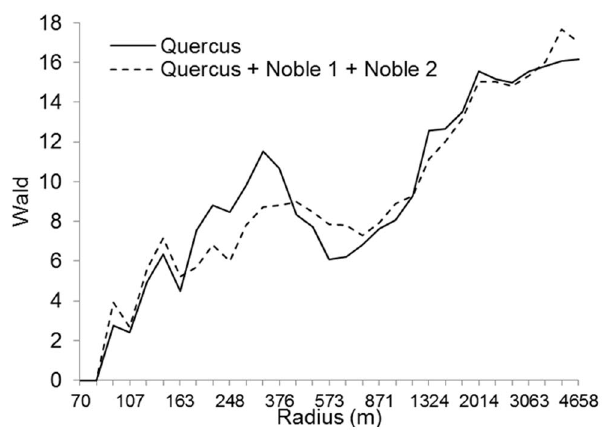
Figure 4. Characteristic scale of response for Elaterferrugineus using two models. i) Pooled density of trees within the groups Quercus , Noble 1 and Noble 2, and ii) density of Quercus only. The grey line indicates p , 0.05, corresponding to Wald value 3.9.